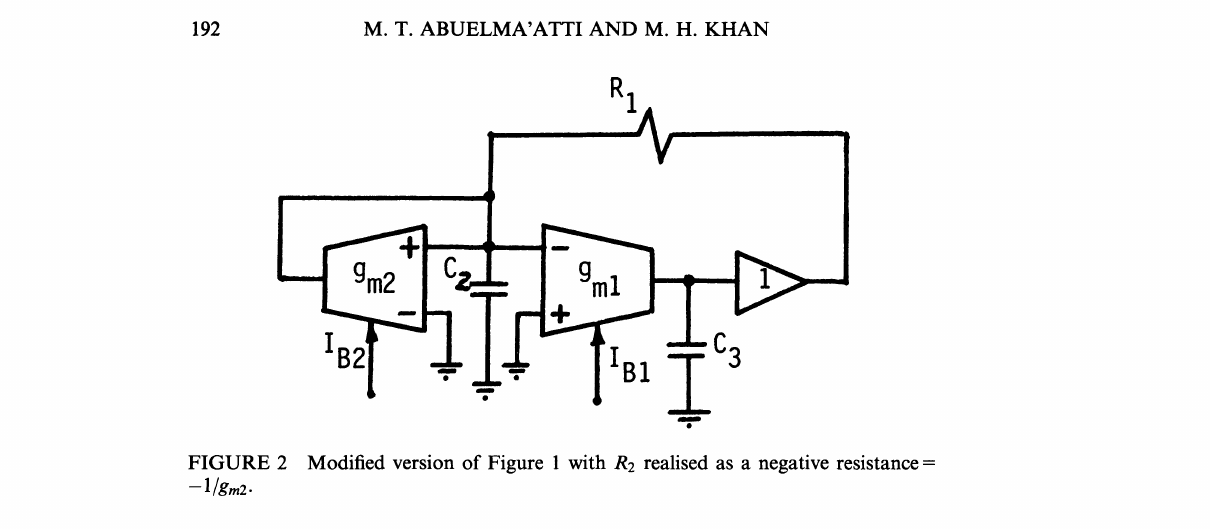
FIGURE 2 Modified version of Figure with R2 realised as a negative resistance